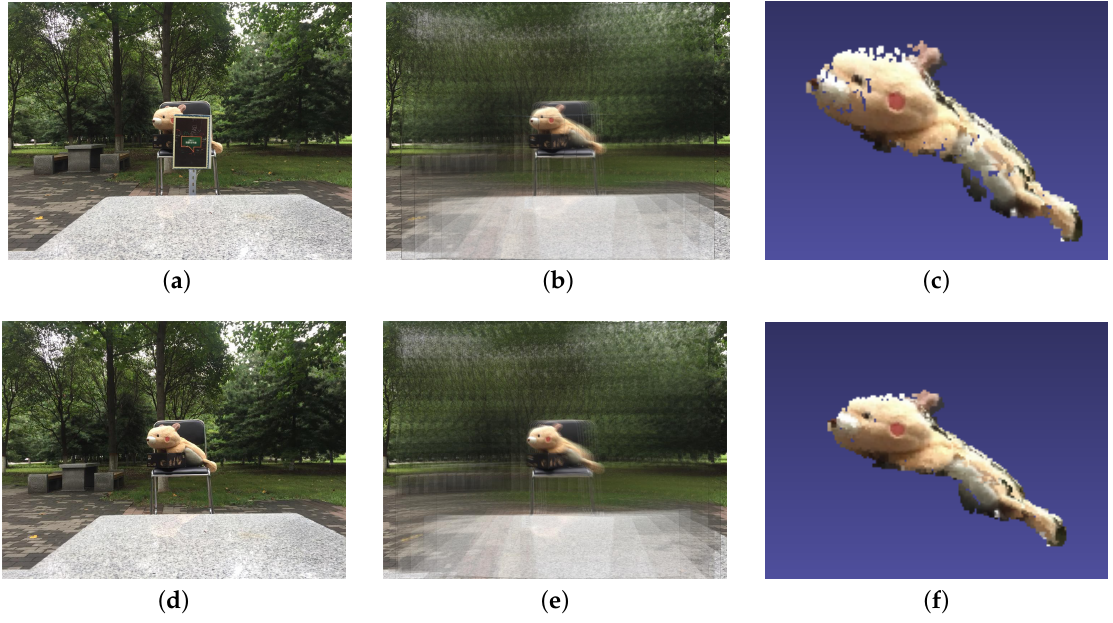
Figure A3. Outdoor scene. ( a ) Toy-bear scene with occlusion in reference camera view. ( b ) Synthetic aperture imaging with occlusion. ( c ) Reconstructed toy bear with occlusion. ( d ) Toy-bear scene without occlusion in reference camera view. ( e ) Synthetic aperture imaging without occlusion. ( f ) Reconstructed toy bear without